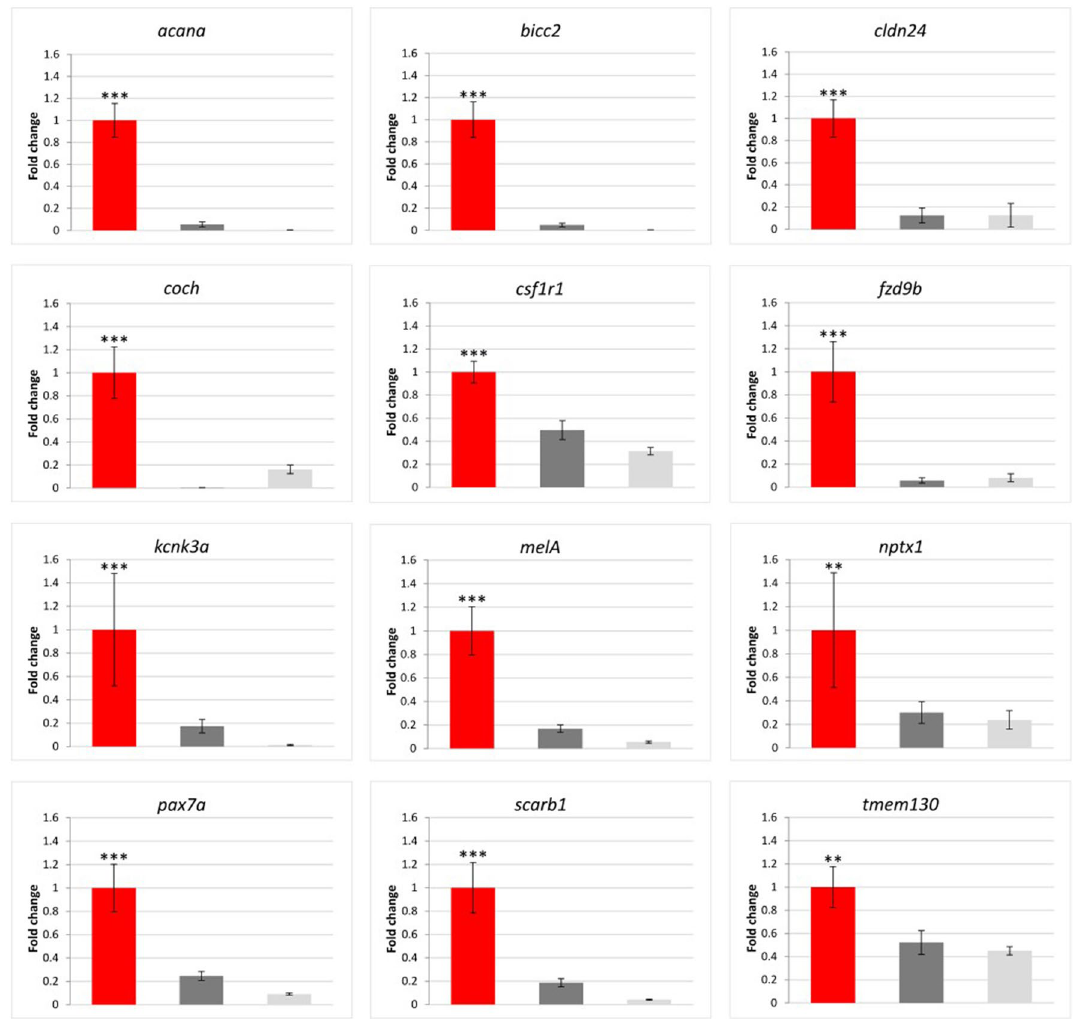
Figure 5. Gene expression patterns obtained with qPCR. Fold changes are expressed as the ratio of gene expression after normalisation to the reference genes. The error bars represent the mean ± SE, and the bars are coloured in red (red spots), dark grey (black spots), and light grey (background colour regions). The expression of each gene was compared with its expression in the red spots and statistically evaluated using the unpaired Student’s t-test. All genes were significantly upregulated in the red spots compared with the other two analysed skin regions. ***p < 0.001; **p <